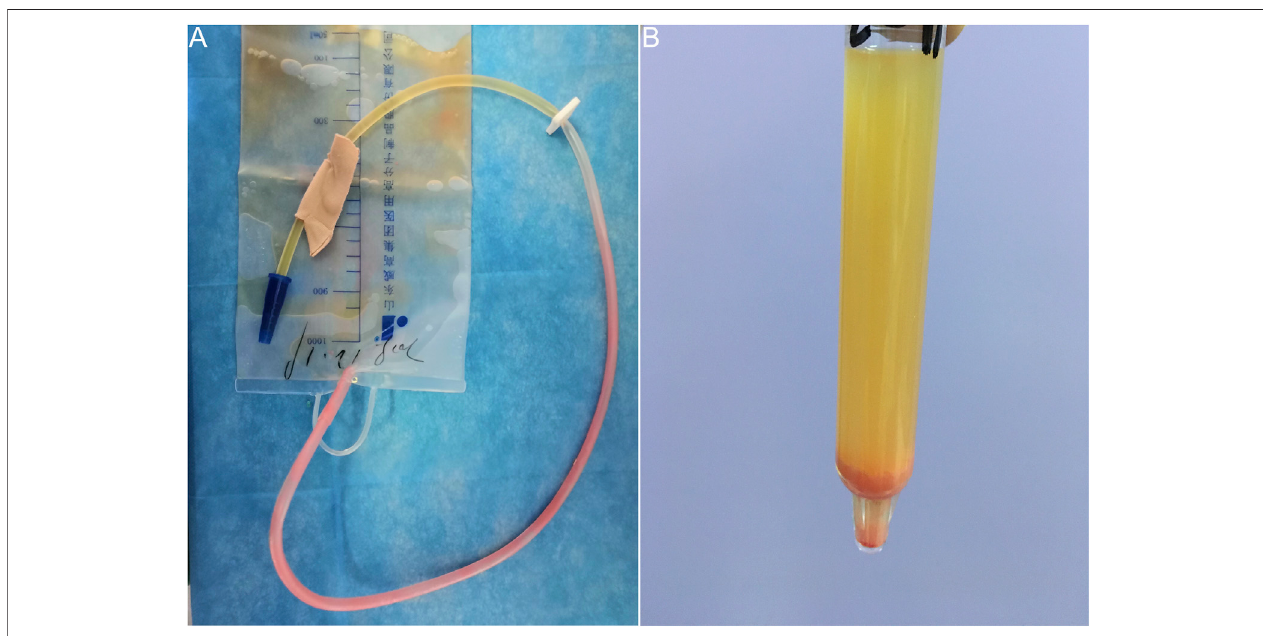
FIGURE1| Pinkurinesyndromeassociatedwithpropofoluseduringgeneralanesthesia. (A) Pinkurineintheurinarydrainagebagandnumerouspinksubstances on walls of the catheter. (B) Pink sediment rapidly precipitated in the urine following centrifugation.